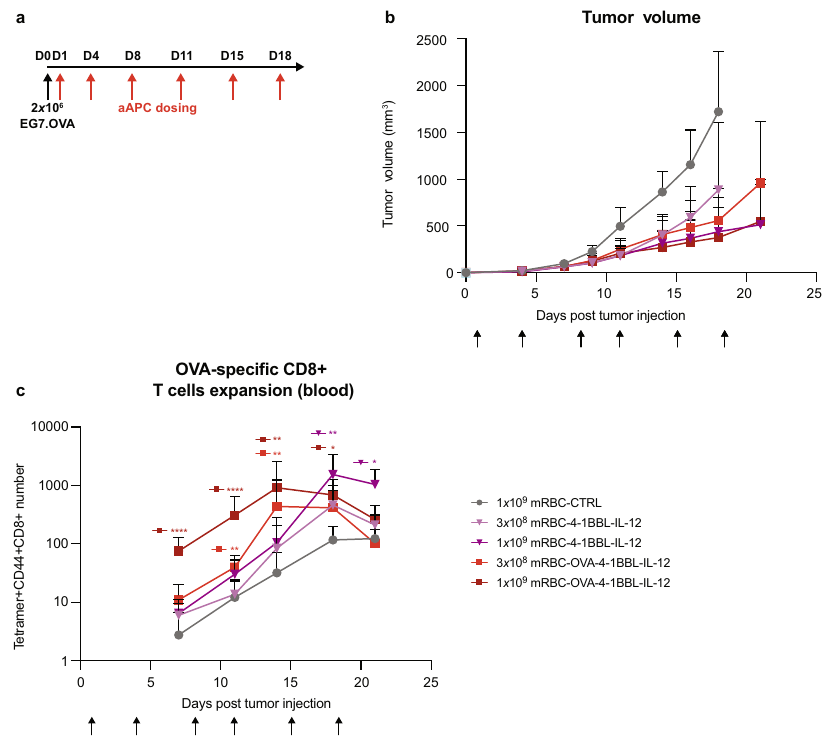
Fig. 4 mRBC-OVA-4-1BBL-IL-12 and mRBC-4-1BBL-IL-12 delays EG7.OVA tumor growth in mice without OT-1 transfer. a C57BL/6 mice were inoculated subcutaneously with 2 × 10 6 EG7.OVA cells. Following that, 1 × 10 9 mRBC-CTRL, or a dose titration of mRBC-4-1BBL-IL-12 or